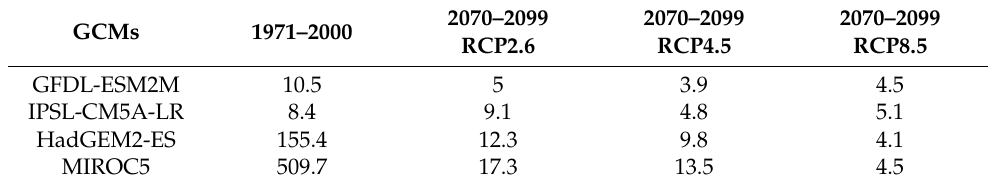
Table 4. The return years of the 1998 peak flood discharge at Cuntan station within the UYRB for the 1971–2000 reference period and 2070–2099 under three RCP scenarios. The unit is